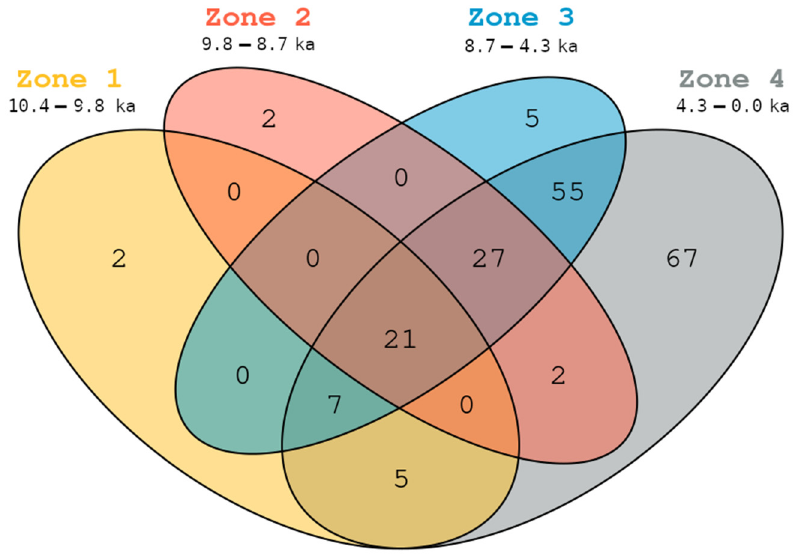
Figure 3. Number of plant taxa identified in the sed aDNA analyses that are shared between CONISS demarcated zones.